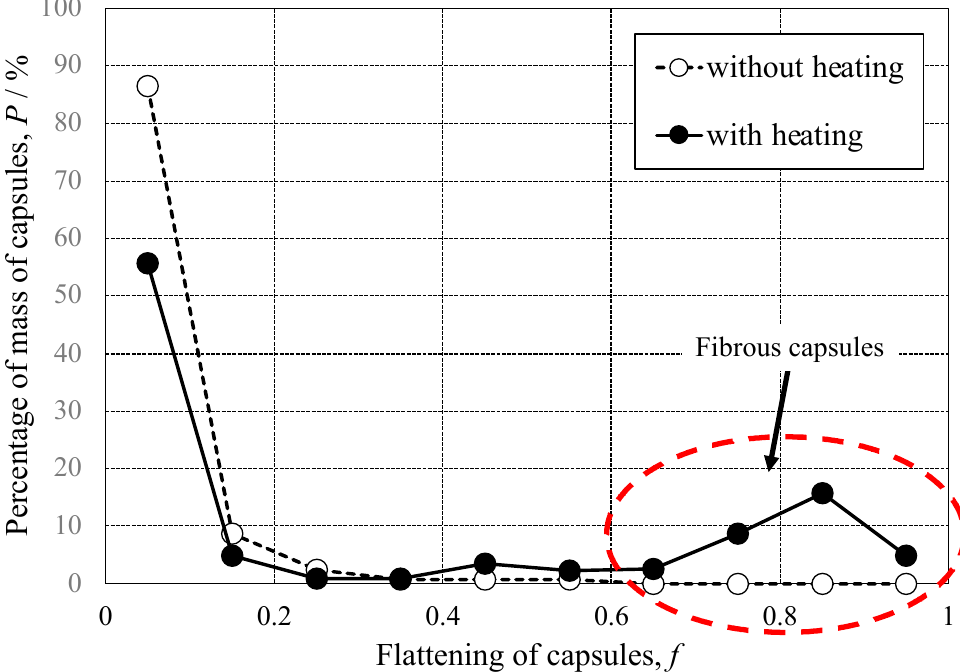
Figure 7. Flattening factor distribution of the capsules synthesized from the prepolymer without and with heating.